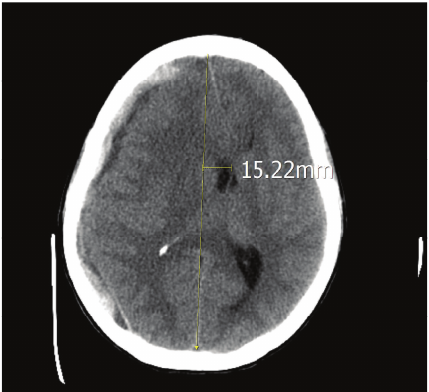
Figure 1: Computed tomography axial image showing right subdu- ral hematoma with midline shift.